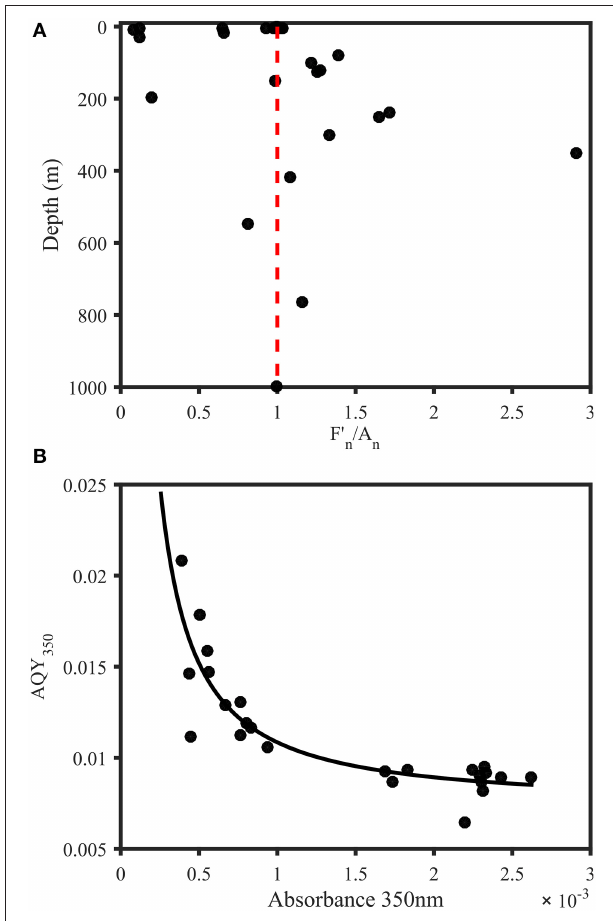
FIGURE 5 | Trends in AQYs of natural samples from the Norwegian shelf and Skagerrak. (A) Depth profile of F 350 / 450 divided by A 350 (both normalized to station maximum) for samples from 11 stations in the Norwegian Sea and Skagerrak ( n = 28 ). Red line indicates a ratio of 1 and represents equal relative contribution of fluorescence and absorbance. Subsurface waters were characterized by a strong fluorescence contribution, with the exception of two samples with abnormally low fluorescence (197 m) and abnormally high absorbance (548 m). Surface waters either showed equal FDOM and CDOM levels or dominant CDOM absorbance contribution. (B) AQY vs. absorbance at 350nm. The black line represents a power fit (a × a 350nmb + c, a = 9 . 821 × 10 − 6 , b = − 1 .181, c = 0.0074 , R 2 = 0.75